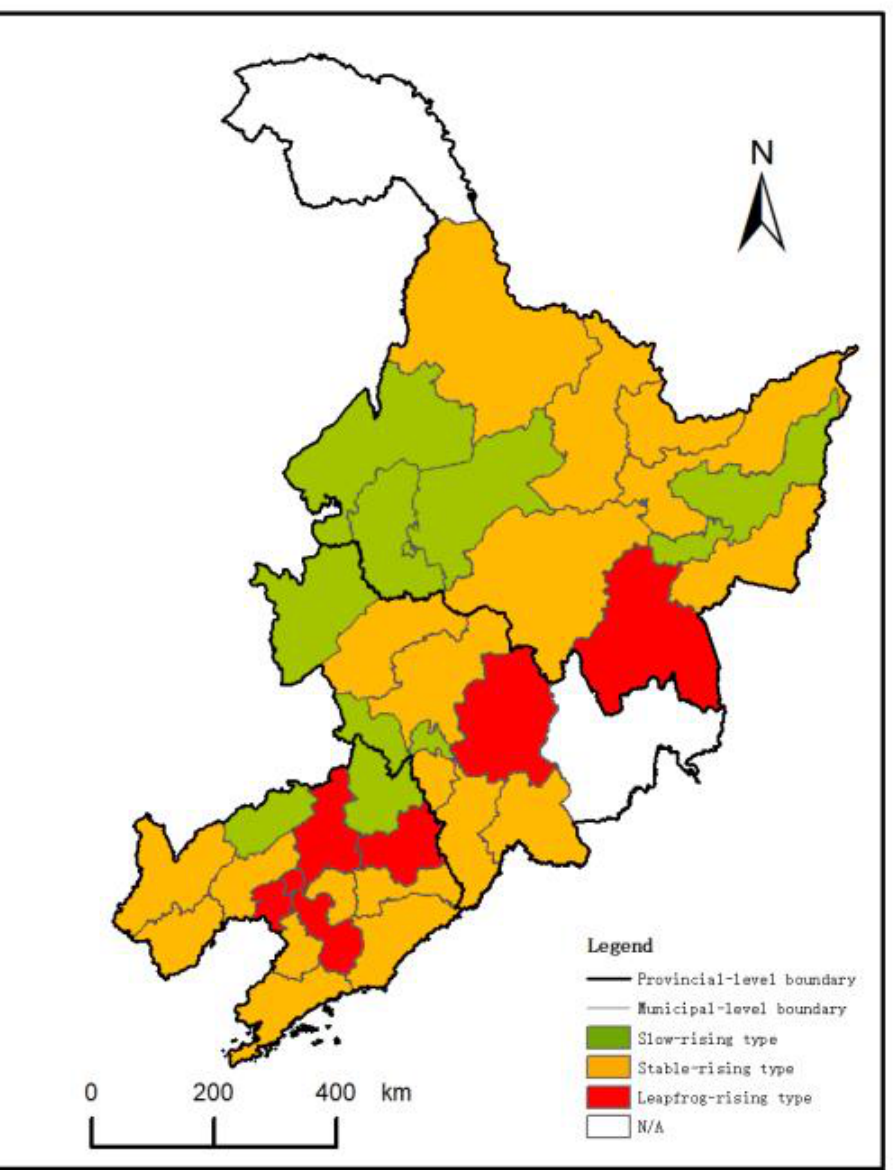
Figure 9. Distribution of Changes of Urban–rural Coupling Coordination Degree Types in North- east China.